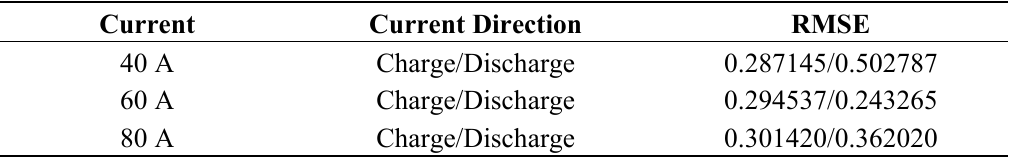
Table 2. Root Mean Squared Error (RMSE) for estimation on the three current